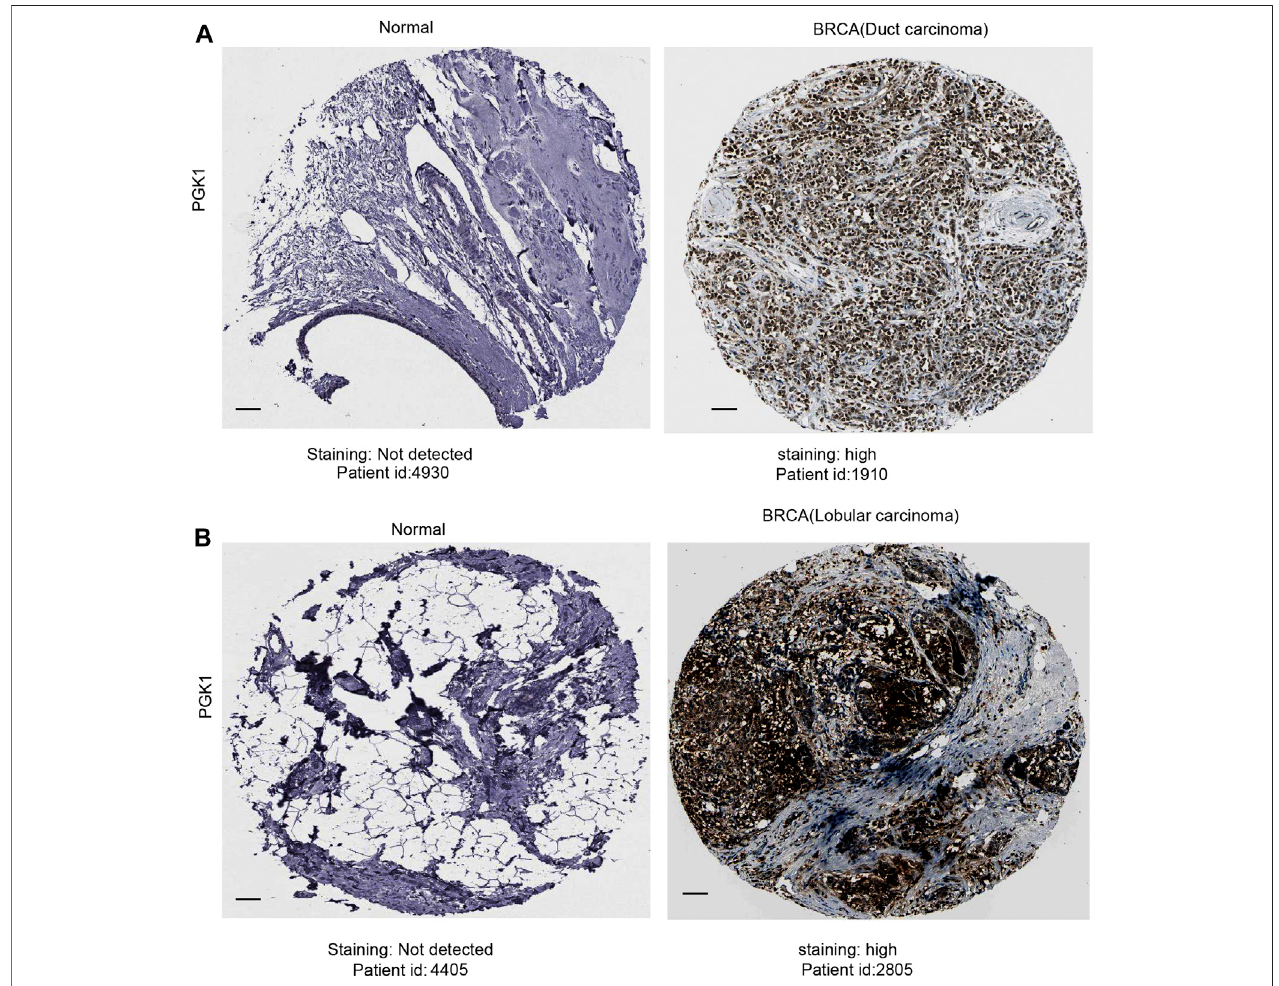
FIGURE 4 | Representative immunohistochemistry images of PGK1 in duct carcinoma (A) and lobular carcinoma ( B ) tissues and normal breast tissues (HPA database) were shown. Scale bar: 50 μ M.